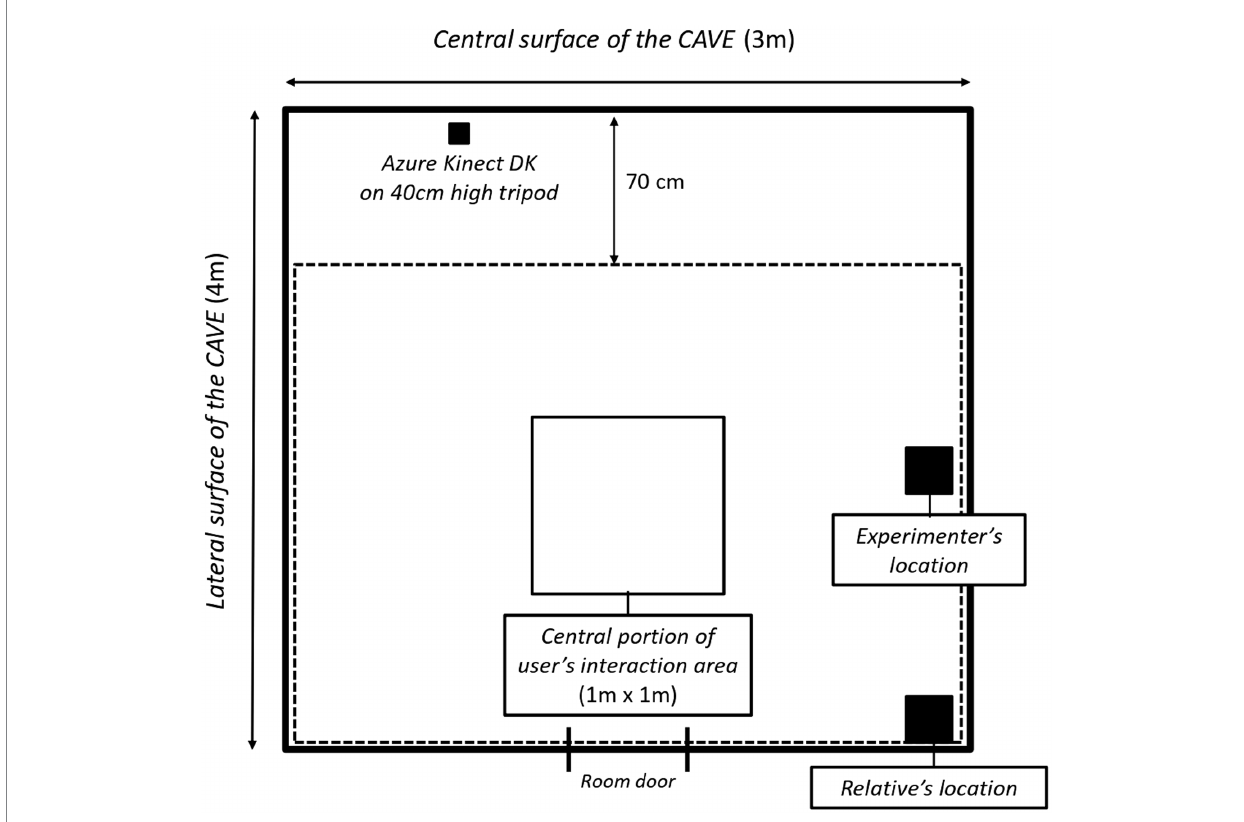
FIGURE 1 Experimental setting representation. Please note that figure is not scaled according to real dimensions. The dotted line enclosed the user’s interaction area in which participants could interact virtually with the system, and in which the body tracking was guaranteed. The biggest filled-black squares represented the experimenter’s location during the study and the relative’s location (if their presence was required due to participant’s